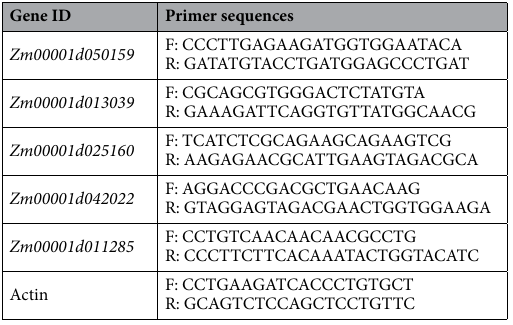
Table 5. Real-time quantitative primers for different expression